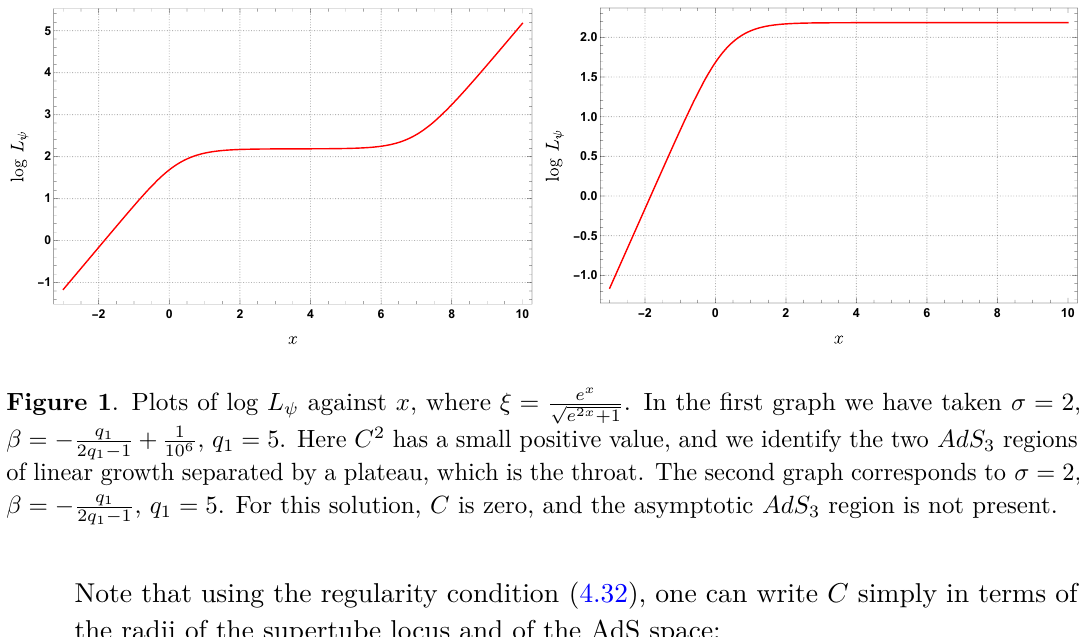
Figure 1 . Plots of log L ψ against x , where ξ = e x √ + 1 , q = 5 . Here C 2 has a small positive value, and we identify the two AdS β = − q 1 1 2 q 1 − 1 10 6 of linear growth separated by a plateau, which is the throat. The second graph corresponds to σ = 2 , , q = 5 . For this solution, C is zero, and the asymptotic AdS β = − q 1 1 2 q 1 − 1